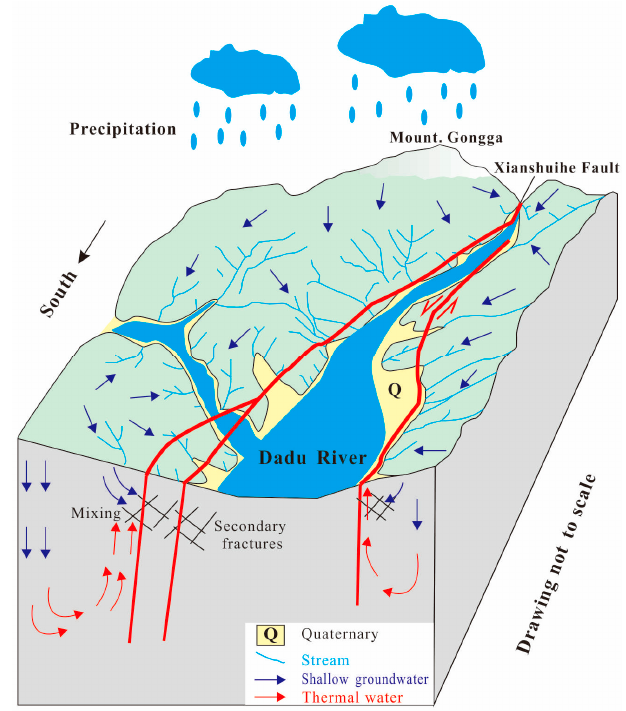
Figure 14. Hydrological conceptual model of natural water system in Kangding County.